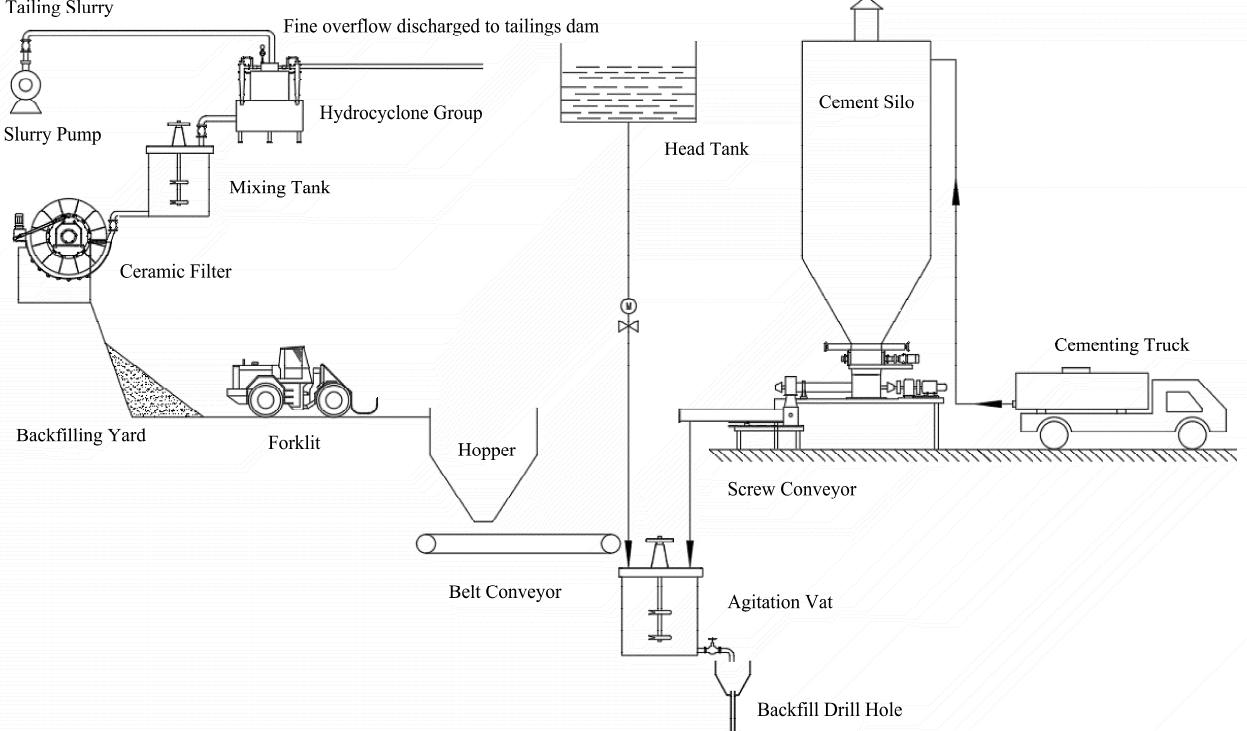
Figure 1. (Source elaborated by authors) Process flow of coarse particle size grading tailings backfill system.